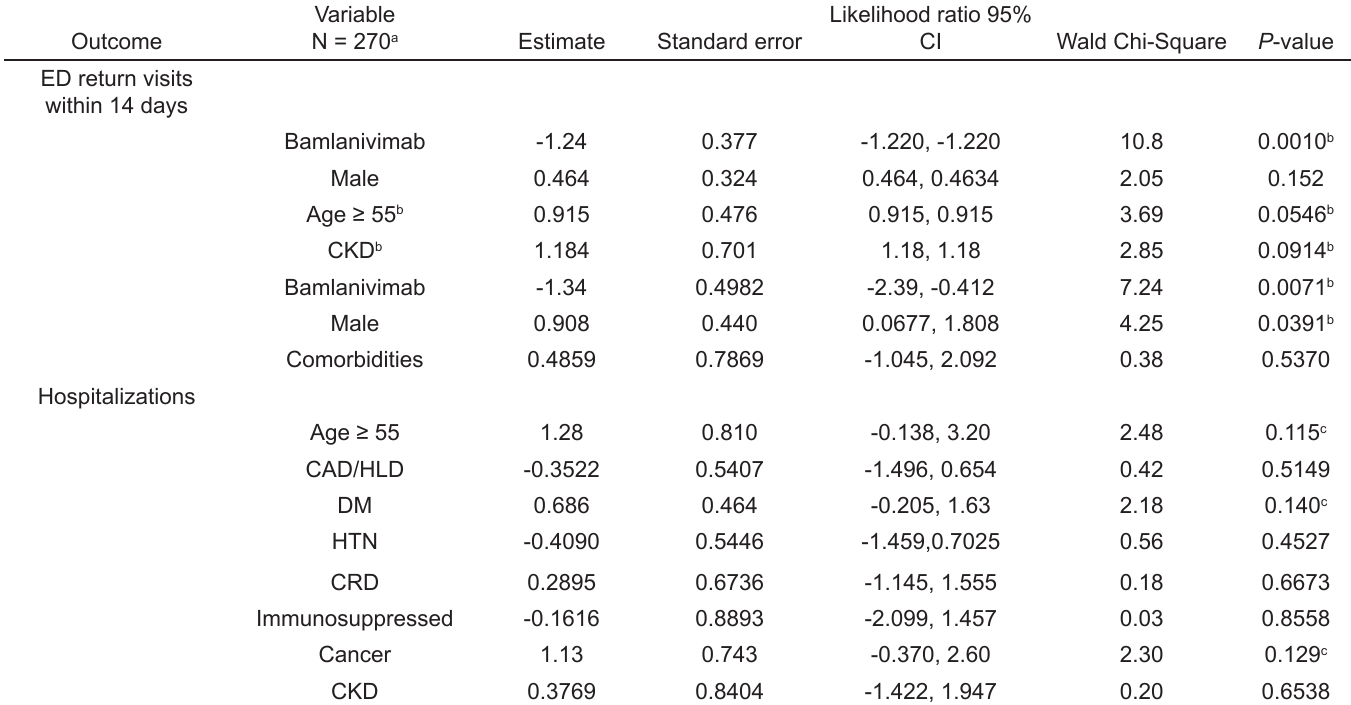
Table 3. Intermediary regression outcome models for COVID-19 ED return visits in 14 days and